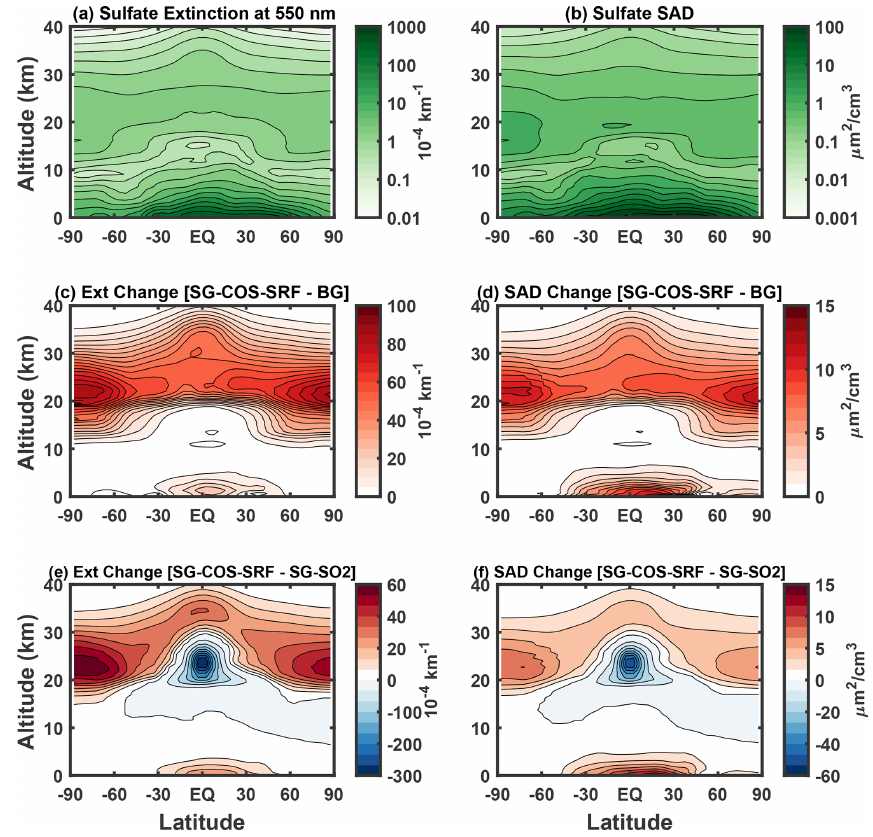
Figure 5. Zonal mean values of sulfate extinction (in 10 − 4 km − 1 ) and SAD (in µm 2 cm − 3 ) in BG (panels a and b , respectively) and their change in the case of the SG-COS-SRF experiment (panels c and d ). Panels (e) and (f) show extinction and SAD changes between SG-COS-SRF and SG-SO2. All quantities are annually averaged over the years 2046–2055. Table 2. Globally and annually averaged dry deposition rates of sulfur species (Tg − Syr − 1 ; years 2046–2055). Note: MSA is methanesul- fonic